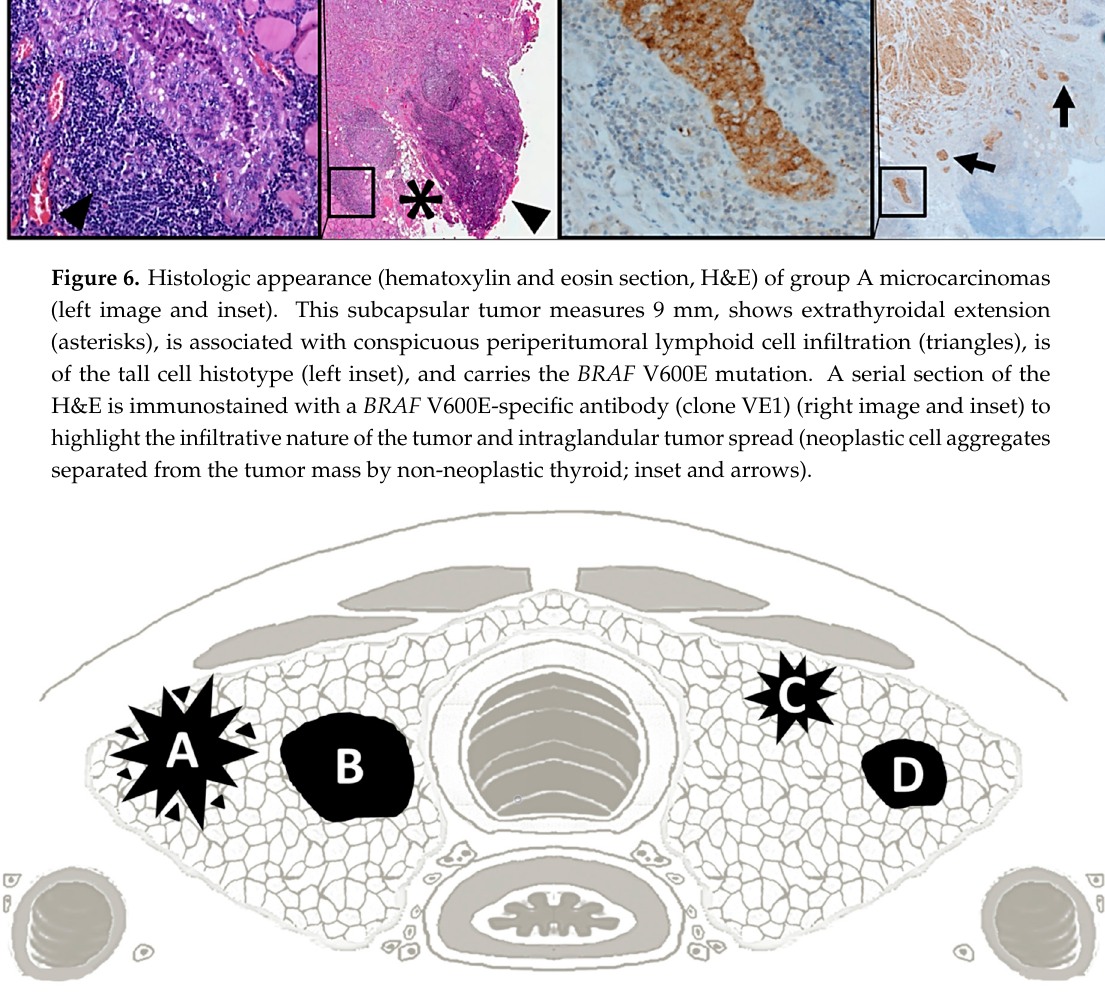
Figure 7. Schematic representation of the microcarcinoma groups A, B, C, and D.